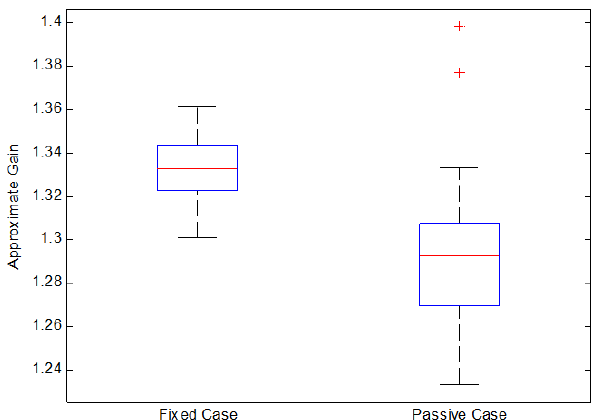
Figure 6. Box Plot: Tire Deflection